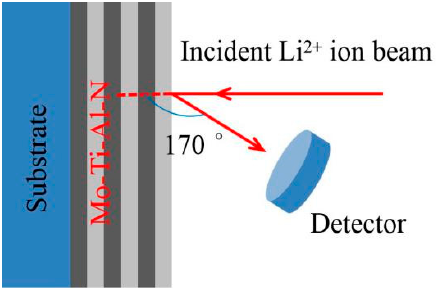
Figure 2. Geometrical schematic of RBS experiments.